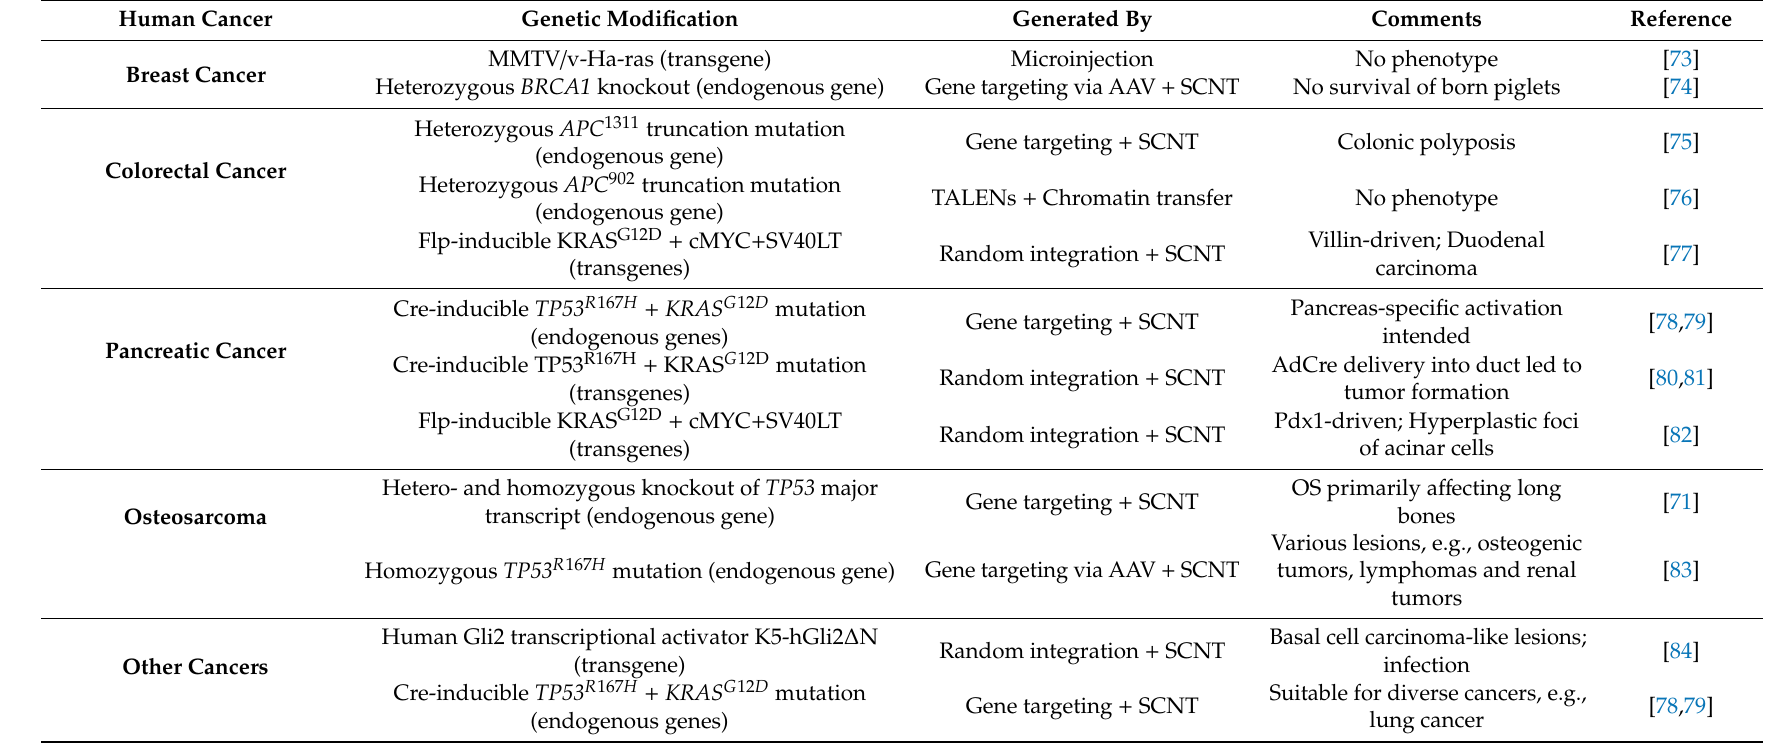
Table 1. Providing an overview of genetically modified pig models for human